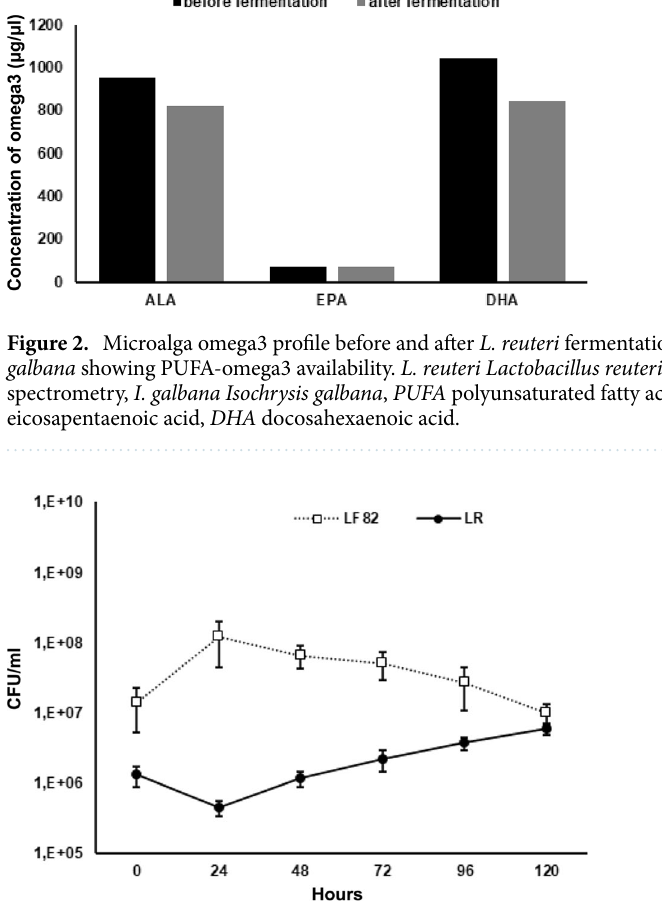
Figure 3. Competitive growth of L. reuteri and AIEC LF82 in I. galbana . Differential growth of LF82 (open square) and L. reuteri (filled circle) in I. galbana. AIEC adherent-invasive Escherichia coli , L. reuteri Lactobacillus reuteri , I. galbana Isochrysis